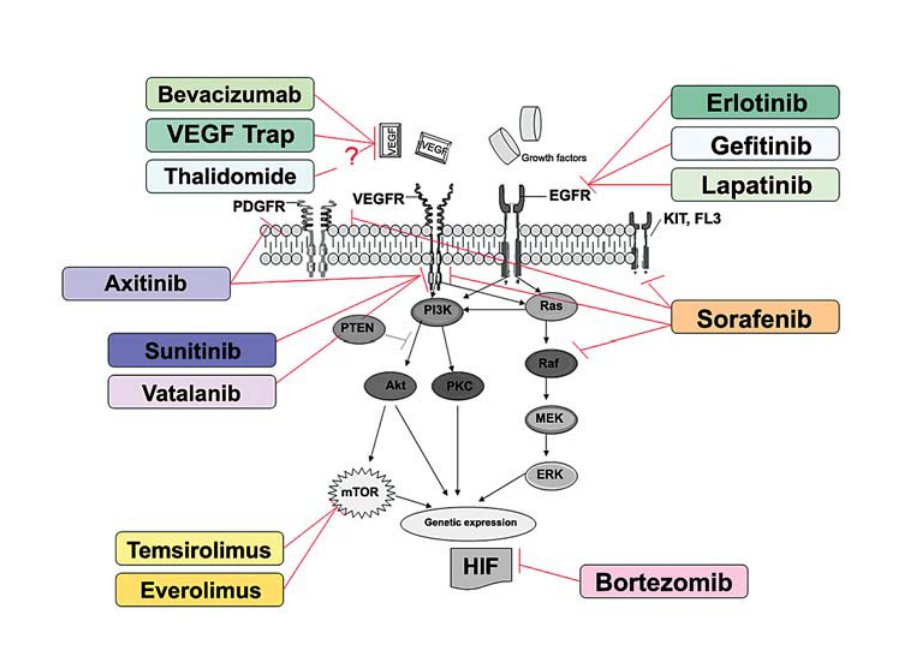
Figure 4 – Therapeutic targets of some anti-angiogenesis therapies for metastatic